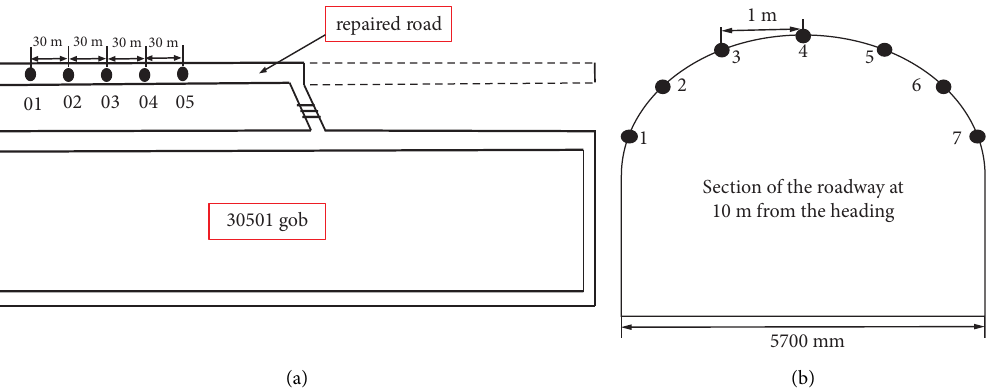
Figure 2: Layout of roadway roof measuring points. (a) Layout of roadway roof measuring points. (b) Layout of section measurement